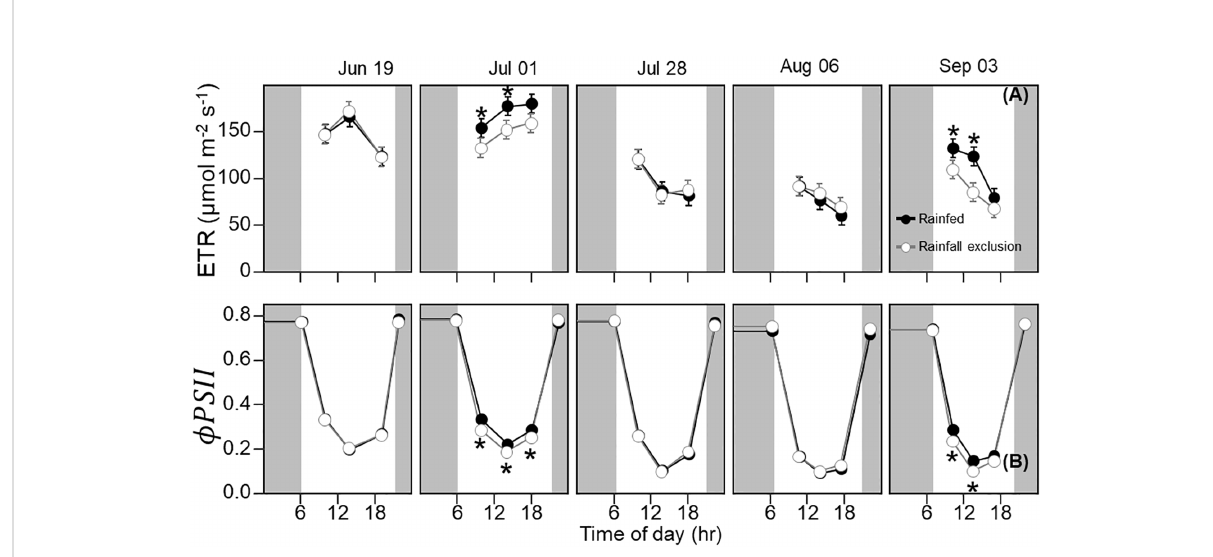
FIGURE 3 Switchgrass electron transport rate ( ETR ; (A) and photosystem II quantum ef fi ciency ( f PSII ; (B) at each timepoint during the day, over the course of the growing season, for plants grown under (white fi ll, grey line) and outside (black fi ll, black line) rainfall exclusion shelters. Asterisks indicate a signi fi cant difference between treatments (P< 0.05). Data are mean ± S.E. (n = 4).